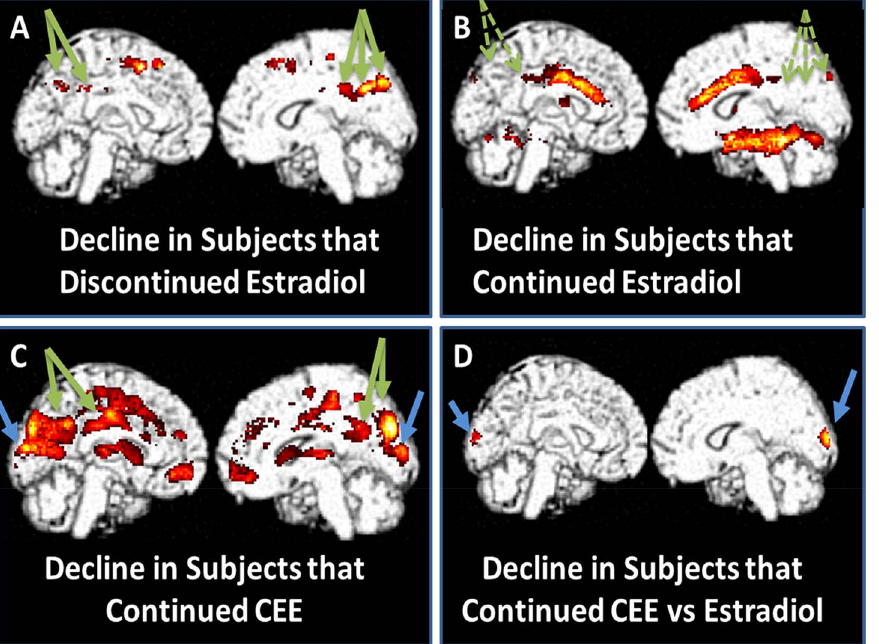
Figure 4. Subjects that discontinued E opposed by progesterone and stayed off HT for two years demonstrated decline in the medial frontal gyrus, while subjects that discontinued unopposed E and stayed off HT for two years demonstrated decline in the precuneous and dorsofrontal cortex. Color voxels shown above have significance p , 0.01.